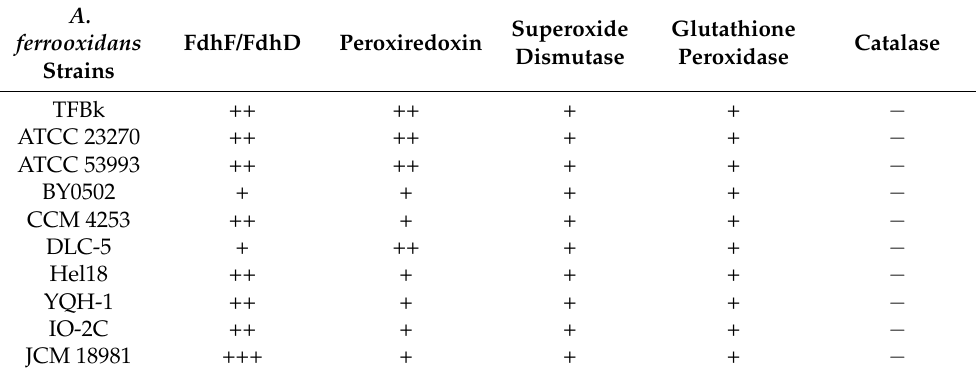
Table 3. Distribution of formate dehydrogenase and oxidative stress enzymes in strains of A. ferrooxidans.